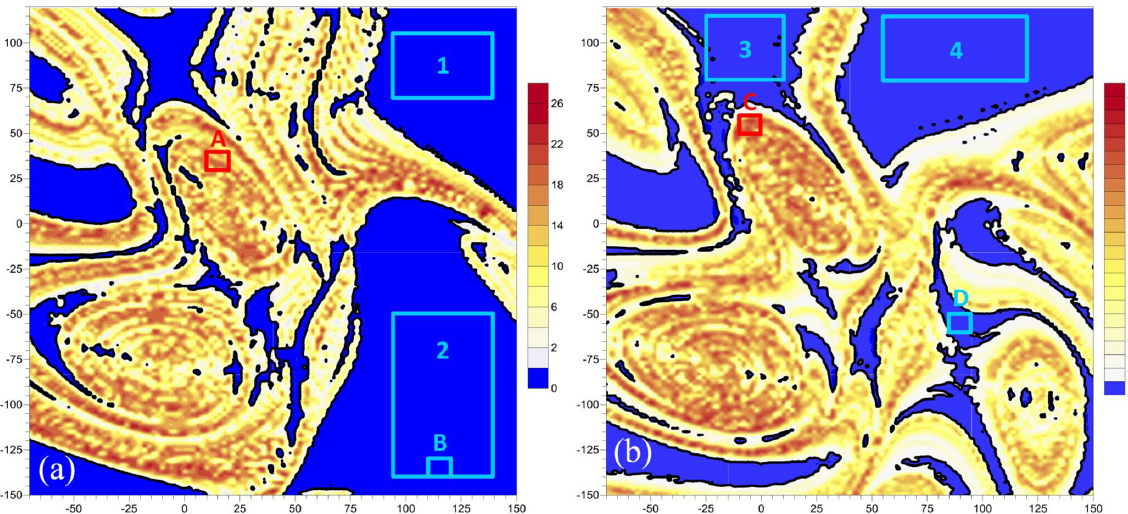
Figure 2. Numerical evidence for the existence of two local pullback attractors (PBAs) in the wind-driven midlatitude ocean circulation. Plotted is a mean normalized distance, (cid:49) , for 15000 trajectories of the double-gyre ocean model of Pierini et al. (2016, 2018); the cold colors correspond to very quiescent behavior, while the warm colors are associated with unstable, chaotic motion on the PBA. The parameter values in the two panels are, respectively, subcritical and supercritical in the autonomous version of the model with respect to the homoclinic bifurcation that gives rise to relaxation oscillations in the latter – (a) γ = 0 . 96 and (b) γ = 1 . 1. Reproduced from Pierini et al. (2016). © American Meteorological Society; used with